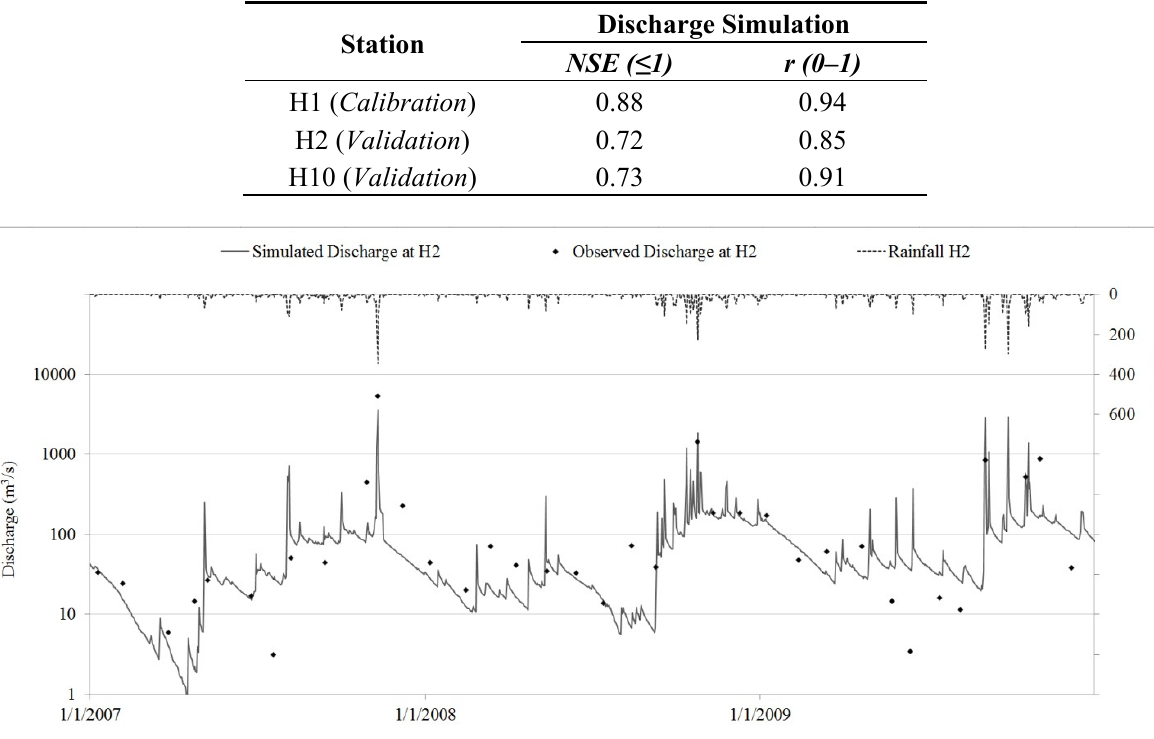
Figure 2. Discharge calibration at H1. Table 2. Performance evaluation statistics of discharge simulation.